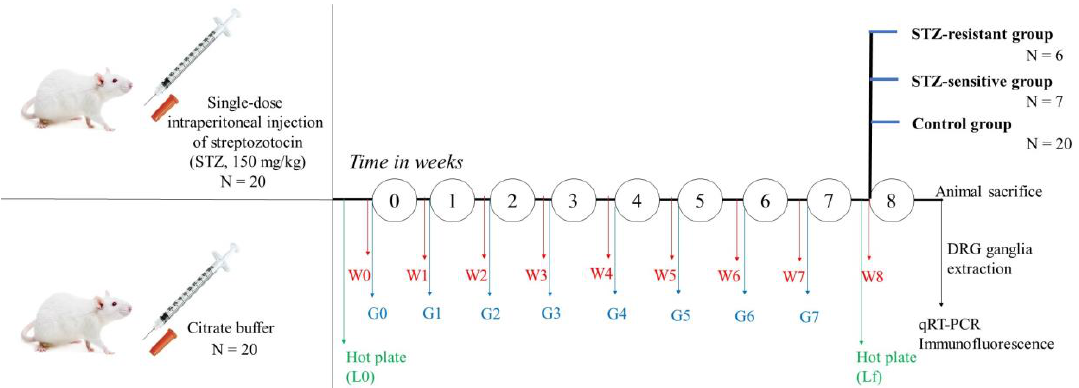
Figure 7. Timeline of the experimental protocol. Abbreviations W-weight, G-glycemia.